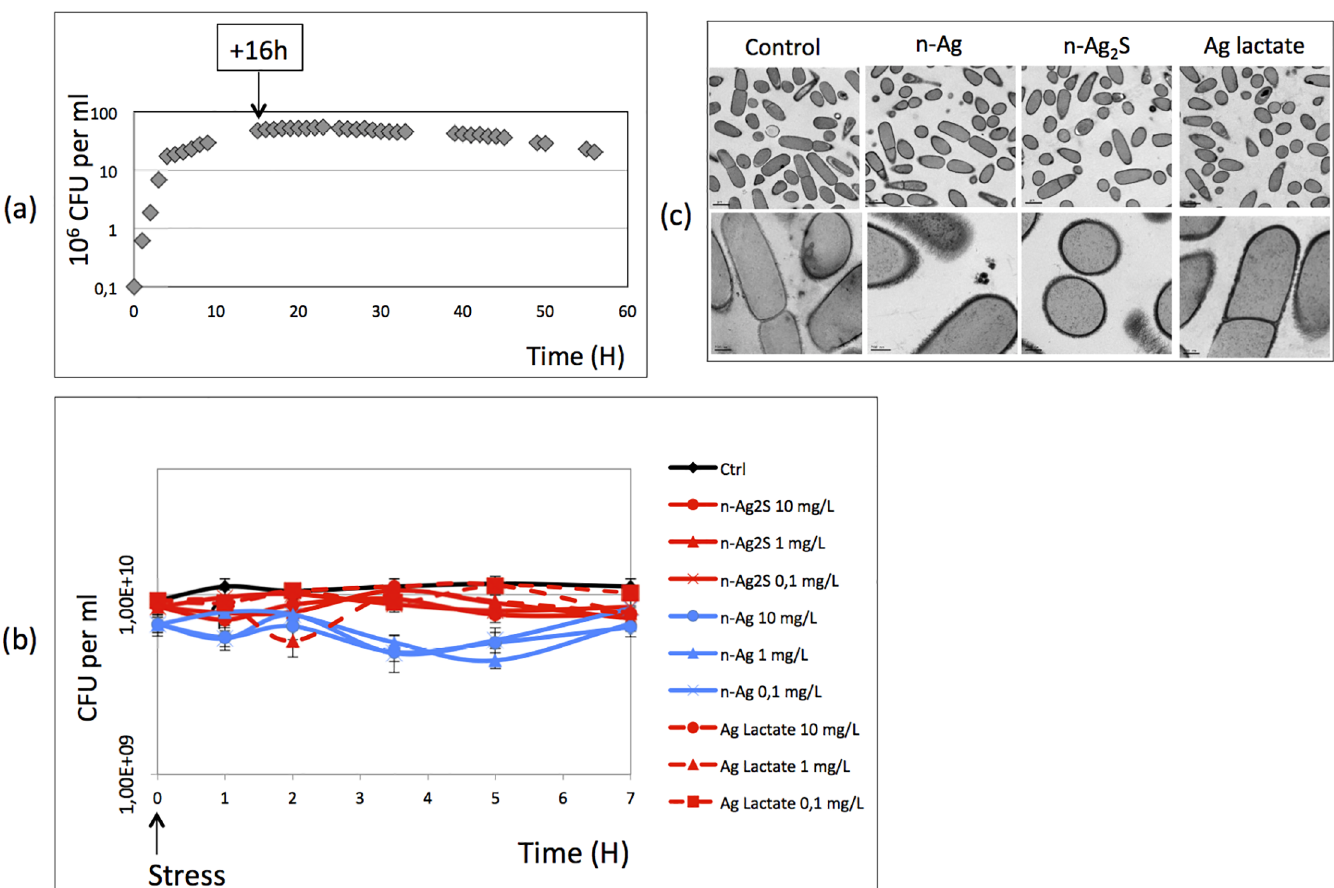
Fig 1. Effect of silver nanoparticles (n-Ag) on Bacillussubtilis growth and morphology. (a) Growth curve of Bacillus subtilis without Ag: diamond, colony-forming unit. (b) Colony-forming unit of Bacillussubtilis exposed to different concentrations (in mg/L) of n-Ag, n-Ag 2 S and silver lactate after 16 h of growth and during 5 h (c) Morphology of Bacillus subtilis after incubation with 1 mg/L of Ag. Scale: 1. μ m in the first line, and 200nm for second line.